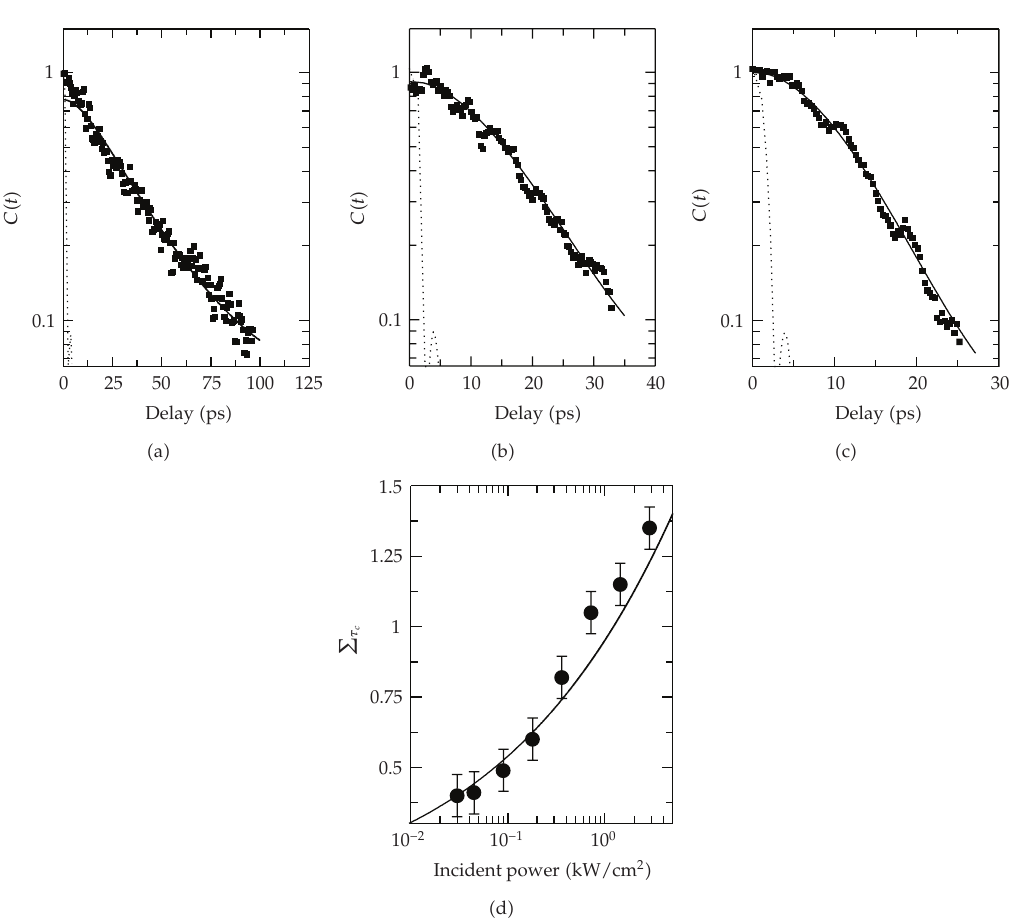
Figure 6: (cid:5) a (cid:6) , (cid:5) b (cid:6) , (cid:5) c (cid:6) : Interferogram contrast C (cid:5) t (cid:6) of the photoluminescence signal of a single InAs/GaAs quantum dot at 10K, on semilogarithmic plots, for three di ff erent incident powers: 0.18 (cid:5) a (cid:6) , 0.72 (cid:5) b (cid:6) , and 2.88kW · cm − 2 (cid:5) c (cid:6) . Data (cid:5) squares (cid:6) , system response function (cid:5) dotted line (cid:6) , theoretical fits (cid:5) solid line (cid:6) obtained by the convolution of the system response function with φ G incident power. Data (cid:5) symbols (cid:6) , and calculations (cid:5) solid lines (cid:6) are plotted as a function of incident power, on a semilogarithmic